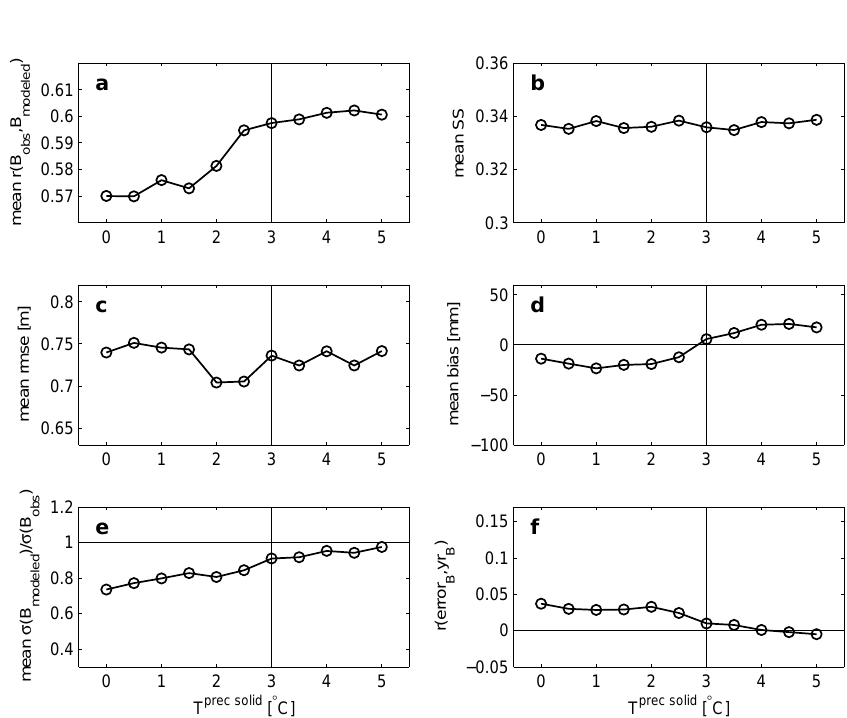
Fig. 6. As Fig. 4, but for the temperature threshold of solid precipitation T prec solid .